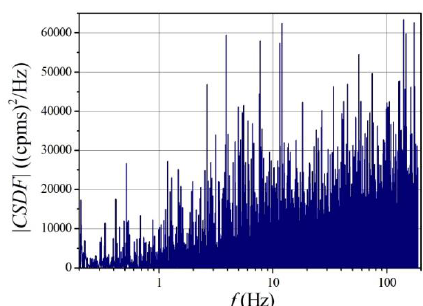
Fig. 4. Module of cross-spectral density function.